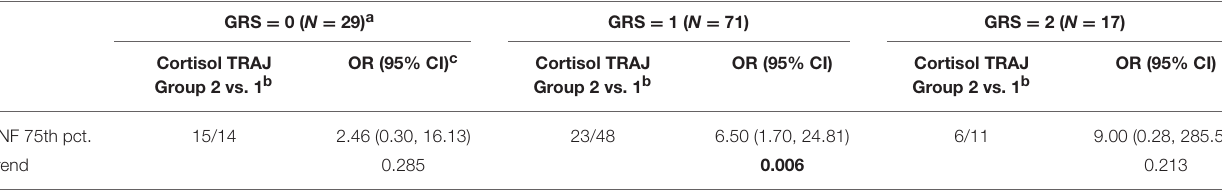
TABLE 4 | Odds Ratios and 95% Confidence Intervals for CSF BDNF and cortisol